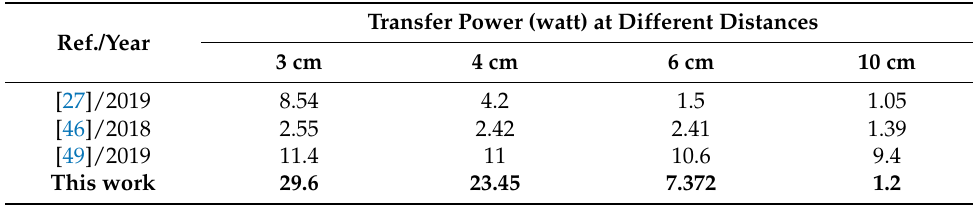
Table 5. Comparison of the current work with previous studies in terms of transfer power. Ref./Year